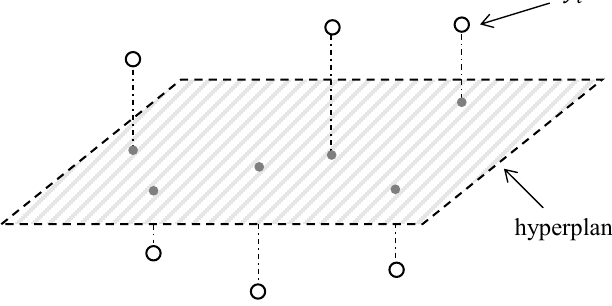
Figure 2. A 3-D example for illustrating the rationality of Equation (7). The round marks denote the bands of the remaining subset Y , and the hyperplane is spanned by X